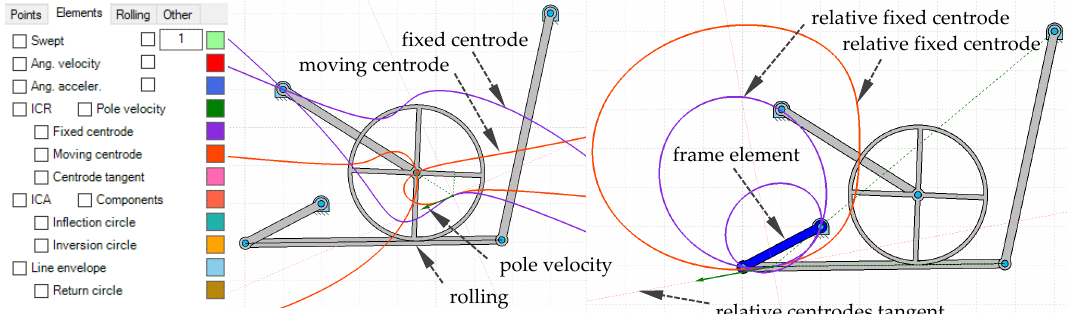
Figure 8. Disk element fixed and moving centrodes in absolute and relative motions. Velocities of poles.